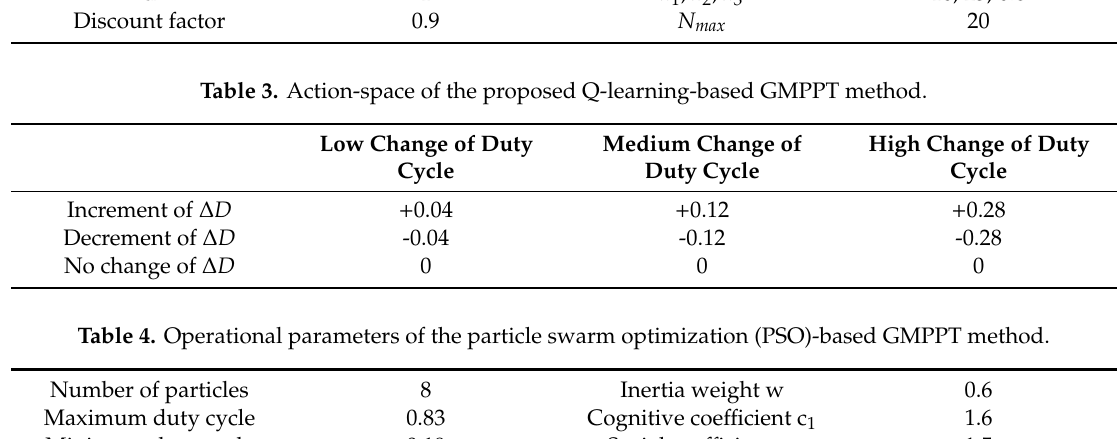
Table 2. Operational parameters of the proposed Q-learning-based GMPPT method. Table 3. Action-space of the proposed Q-learning-based GMPPT method.